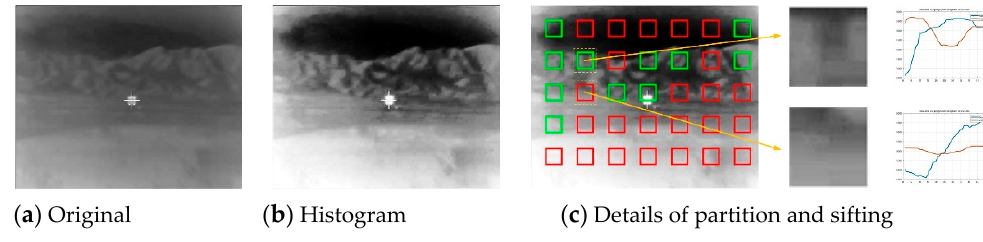
Figure 6. Partition and sifting sub-blocks.